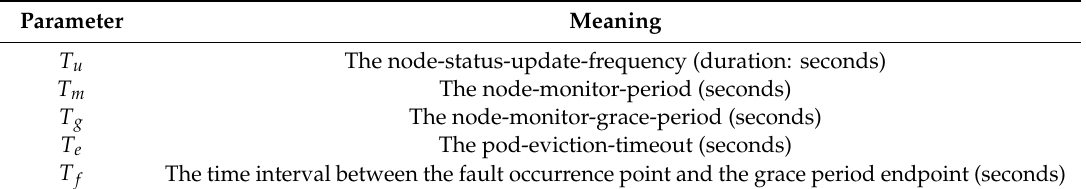
Table 2. Parameters related to the fault-detection